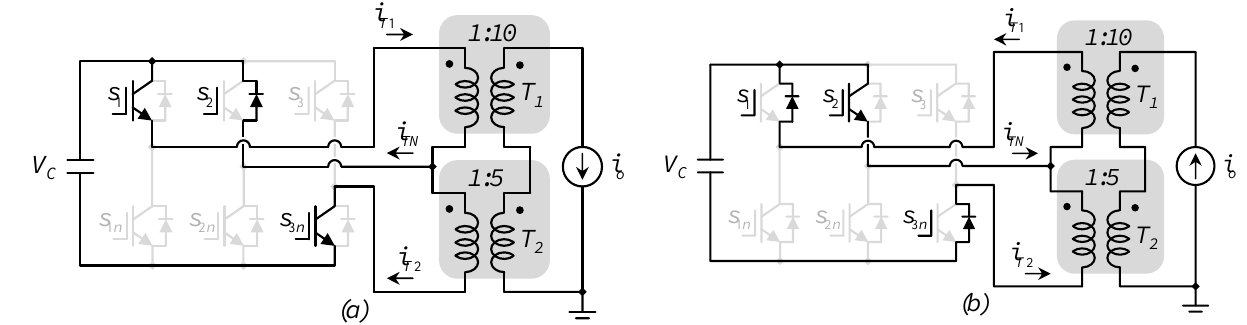
Figure 17. Current flow for different directions of the load current when s 1 = 1, s 2 = 1, and s 3 = 0. (a)